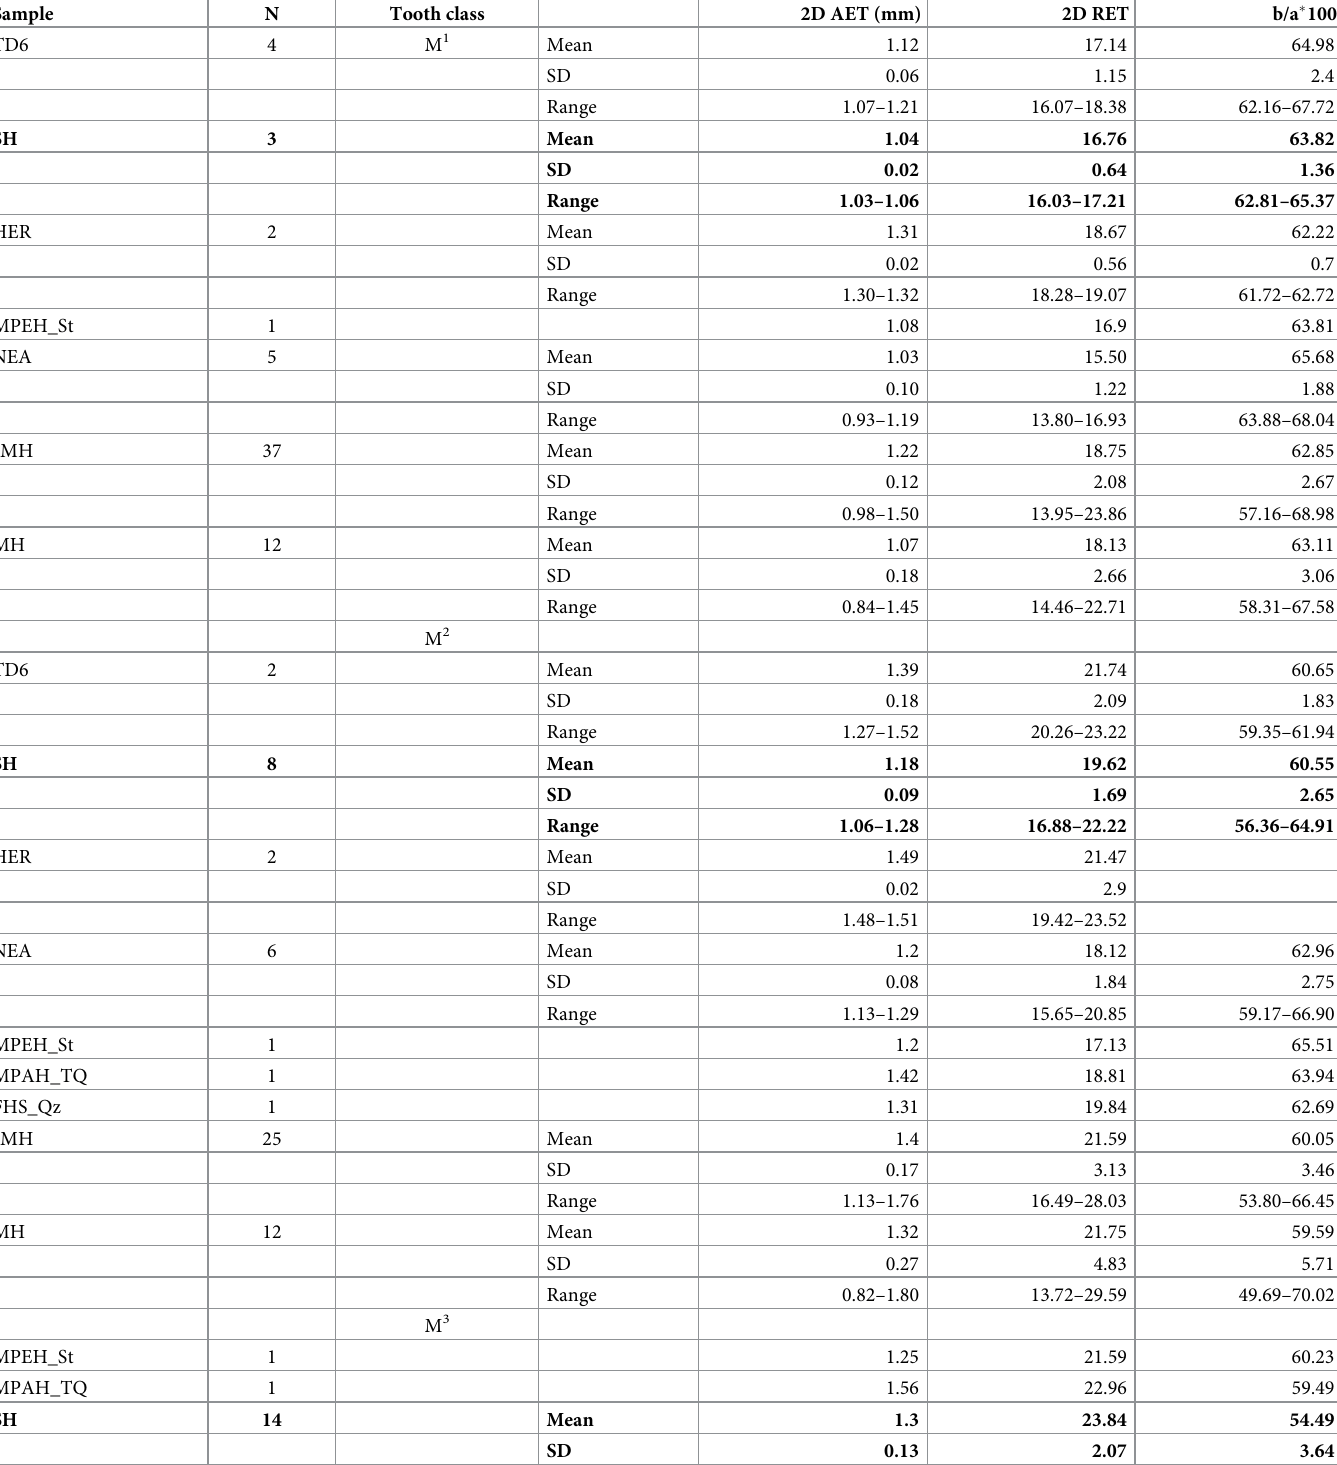
Table 2. 2D enamel thickness variables assessed in SH maxillary and mandibular molars and compared with extinct and extant specimens/populations (SH data in bold). Mean and range are given for the comparative sample when having more than two specimens. Individual values are given for the rest of comparative sample.